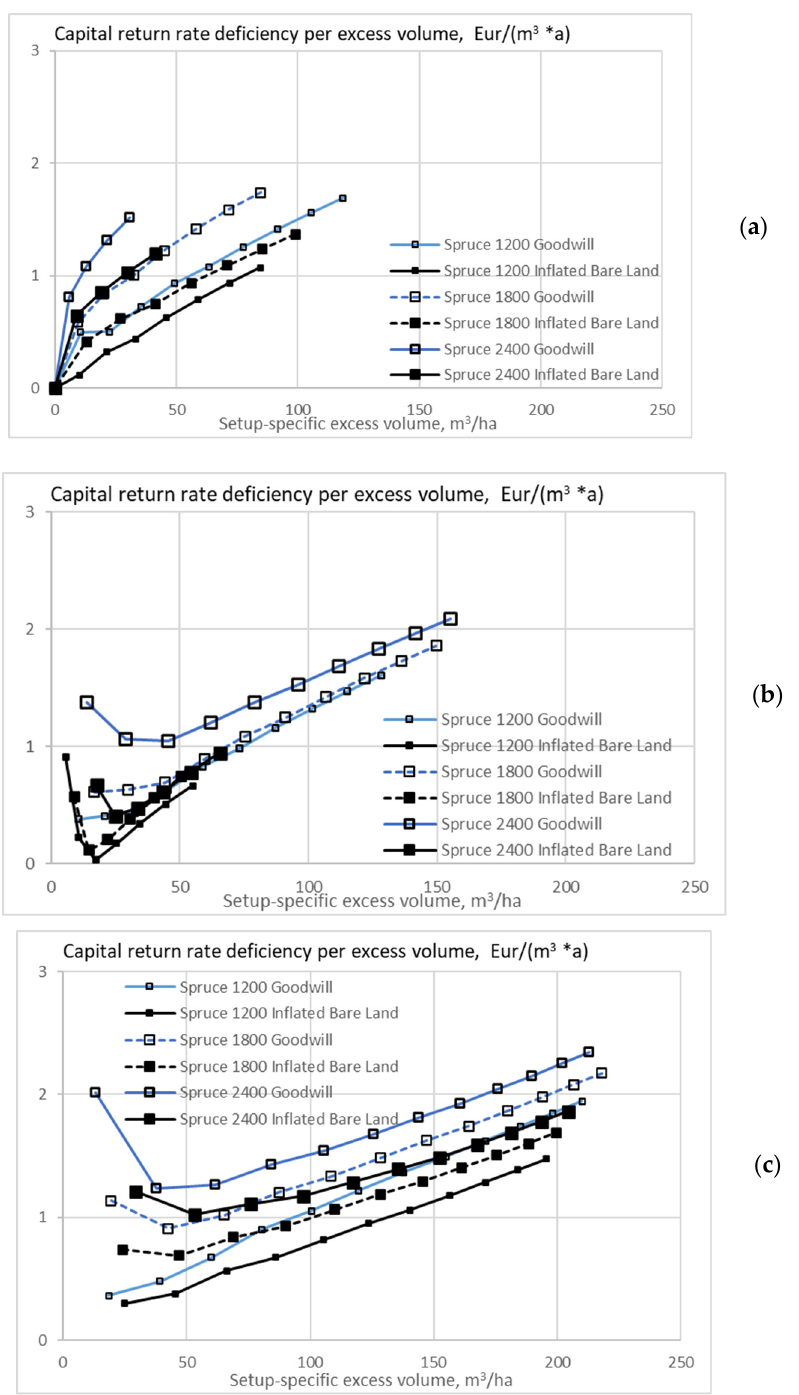
Figure 13. The expected value of capital return rate deficiency per excess volume unit on pine stands of different initial sapling densities, as a function of excess volume, when the growth model is ap- plied as early as applicable, without any thinning restriction ( a ) and in good-quality trees of at least 238 mm of diameter only removed in thinning ( b ), and without any commercial thinning ( c ). Inflated capitalization is introduced either as proportional goodwill or as inflated bare land value.